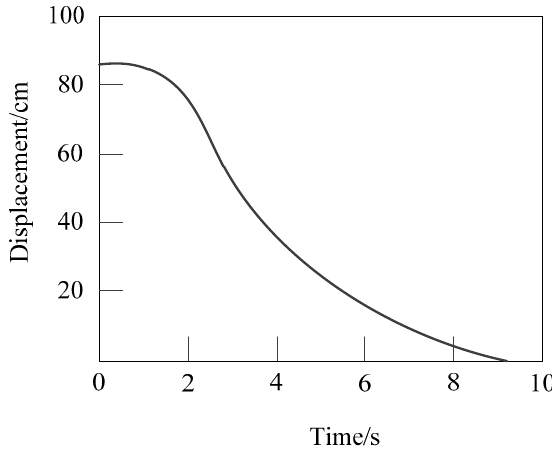
Figure 10. Curve of the boom-piston rod-contraction’s displacement and time.